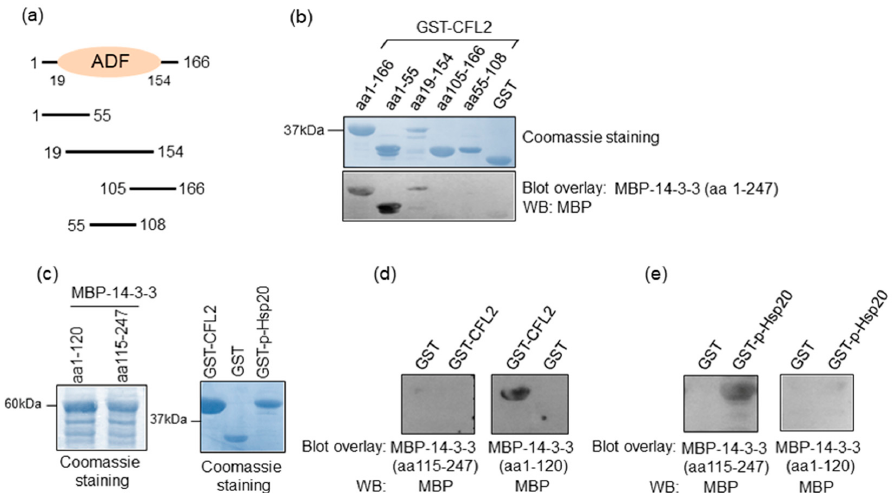
Figure 2. Minimal binding regions of interactions. ( a ) Diagrammatic representation of the various CFL2 deletion constructs. ADF, actin-depolymerizing factor. ( b ) Coomassie blue stained gel showing purified recombinant GST and GST-CFL2 deletion proteins. Blot overlay assays using GST-CFL2 deletion constructs and MBP-14-3-3 determine that 14-3-3 binds to N-terminal region of CFL2 that includes amino acids 1-55. ( c ) Coomassie blue stained gel showing purified MBP-14-3-3 deletion proteins as well as GST-CFL2, GST and GST-p-Hsp20 recombinant proteins. ( d , e ) Blot overlay assays using MBP-14-3-3 N- or C-terminal deletion constructs determine the regions of 14-3-3 that bind to Ser16 phosphorylated-Hsp20 and CFL2. No unspecific binding to MBP was observed in control experiments (Figure S1).